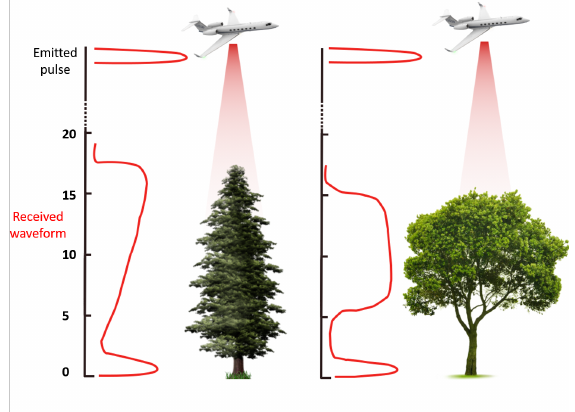
Figure 6. Observed LIDAR waveform versus forest vertical profile.